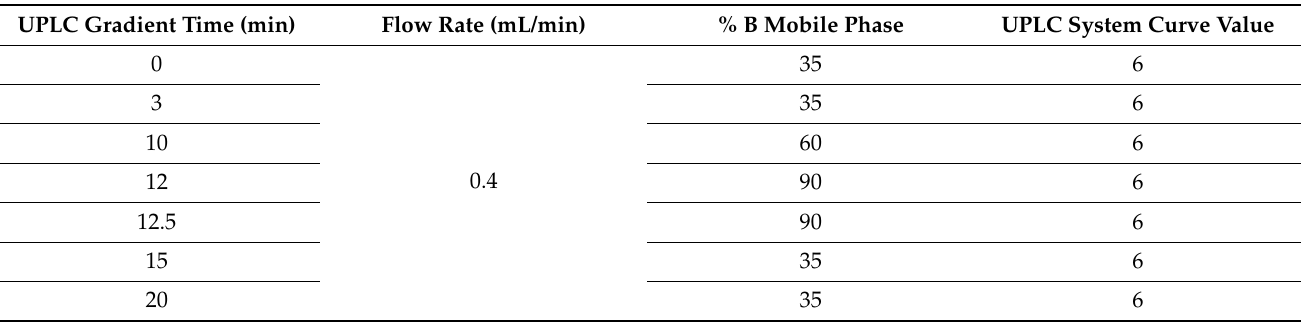
Table 1. Representative CEX UPLC method run program with Mobile phase A and B gradient composition. These system parameters are applicable for waters Binary UPLC system.